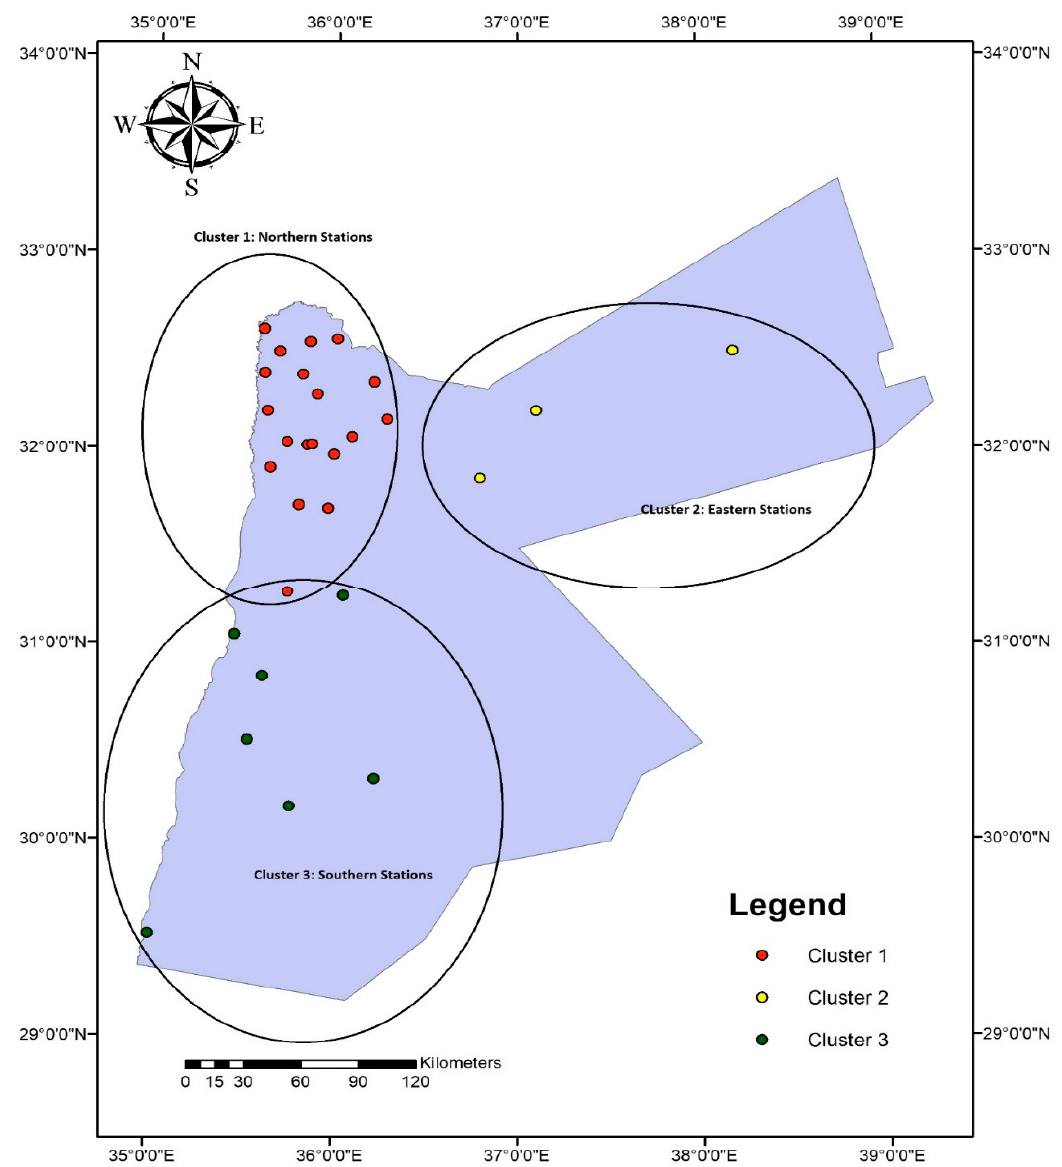
Figure 10. Drought grouping using Ward’s minimum variance method within hierarchical cluster analysis for SPI 12 .